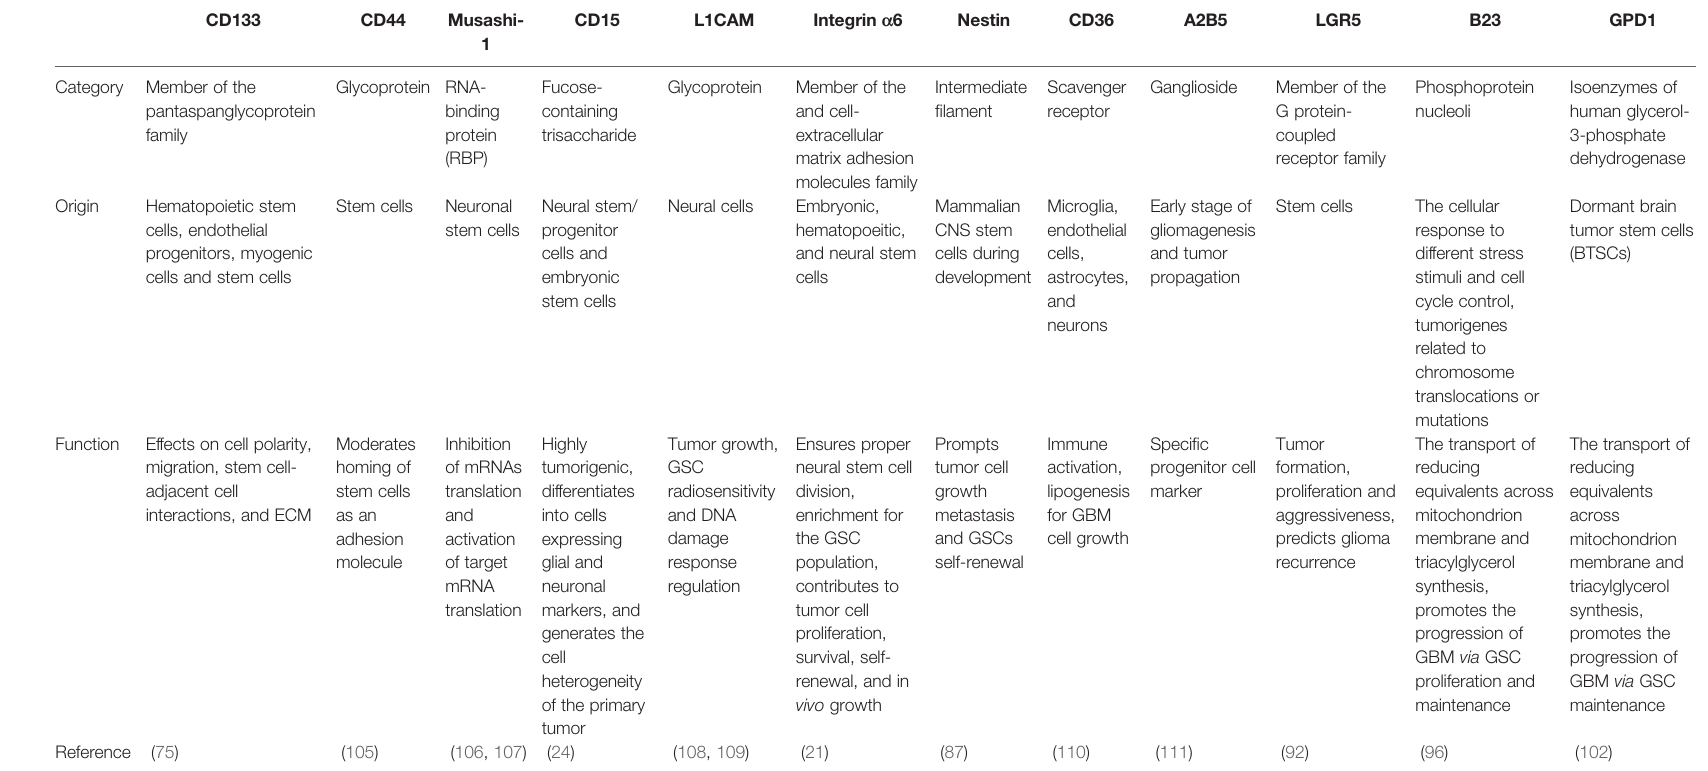
TABLE 1 | Common markers and novel biomarkers on